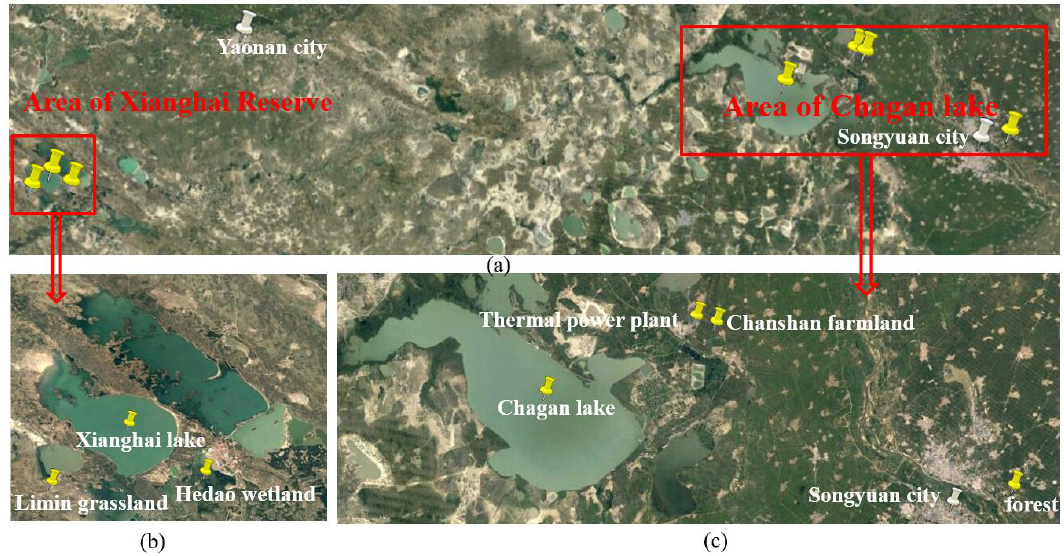
Figure 3. The flight test area showing: ( a ) the overall flight test area; ( b ) Xianghai Reserve; and ( c ) the Changan Lake area.